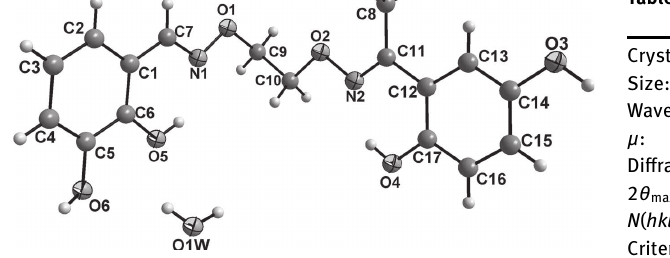
Table 1: Data collection and